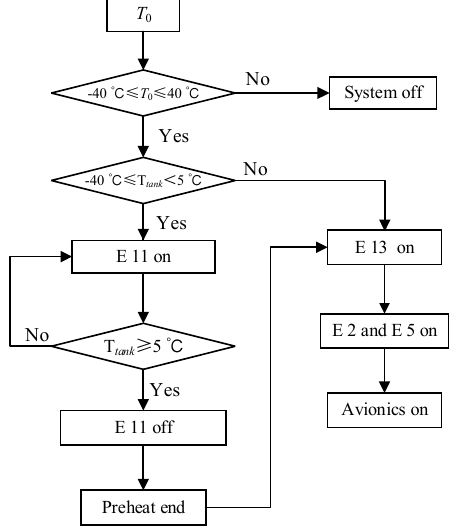
Figure 5. Control strategy of TMS.